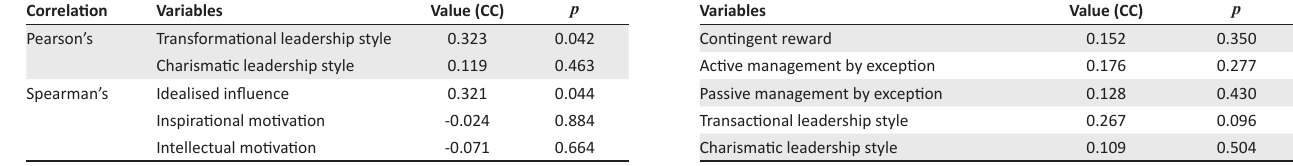
TABLE 3: Intrinsic process motivation and charismatic and transformational leadership styles. Correlation